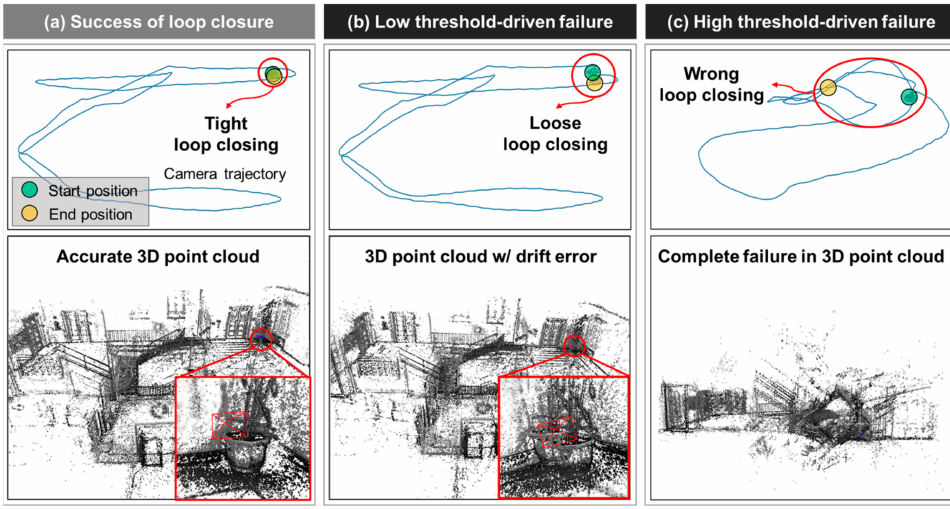
Figure 4. Success and failure cases in loop closure and its resultant 3D point